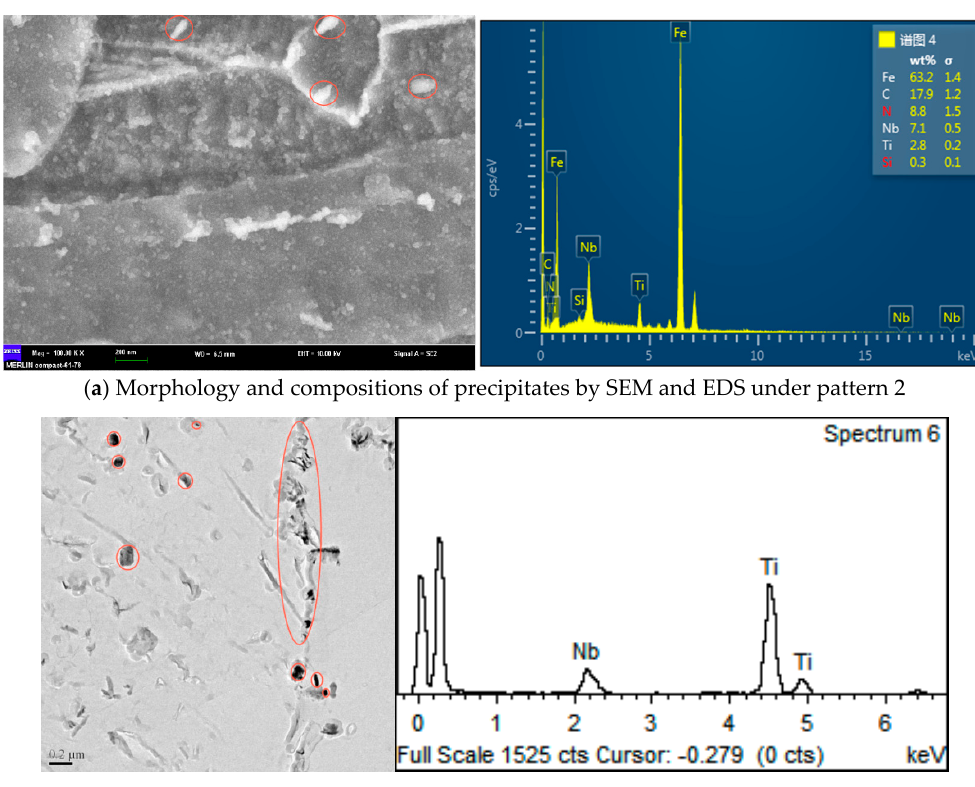
Figure 14. Morphology and compositions of precipitates under different thermal schedules.